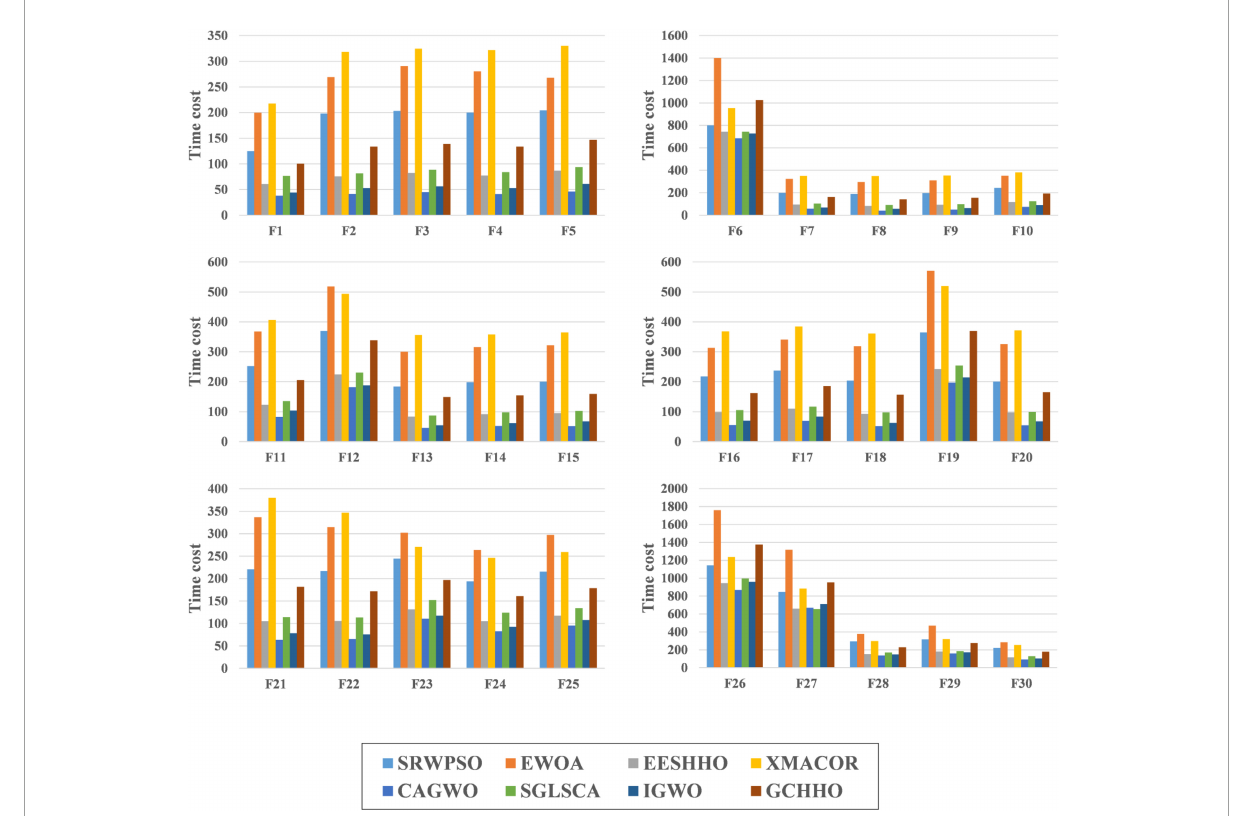
FIGURE15 The time complexity evaluation results of SRWPSO with new peer variants.